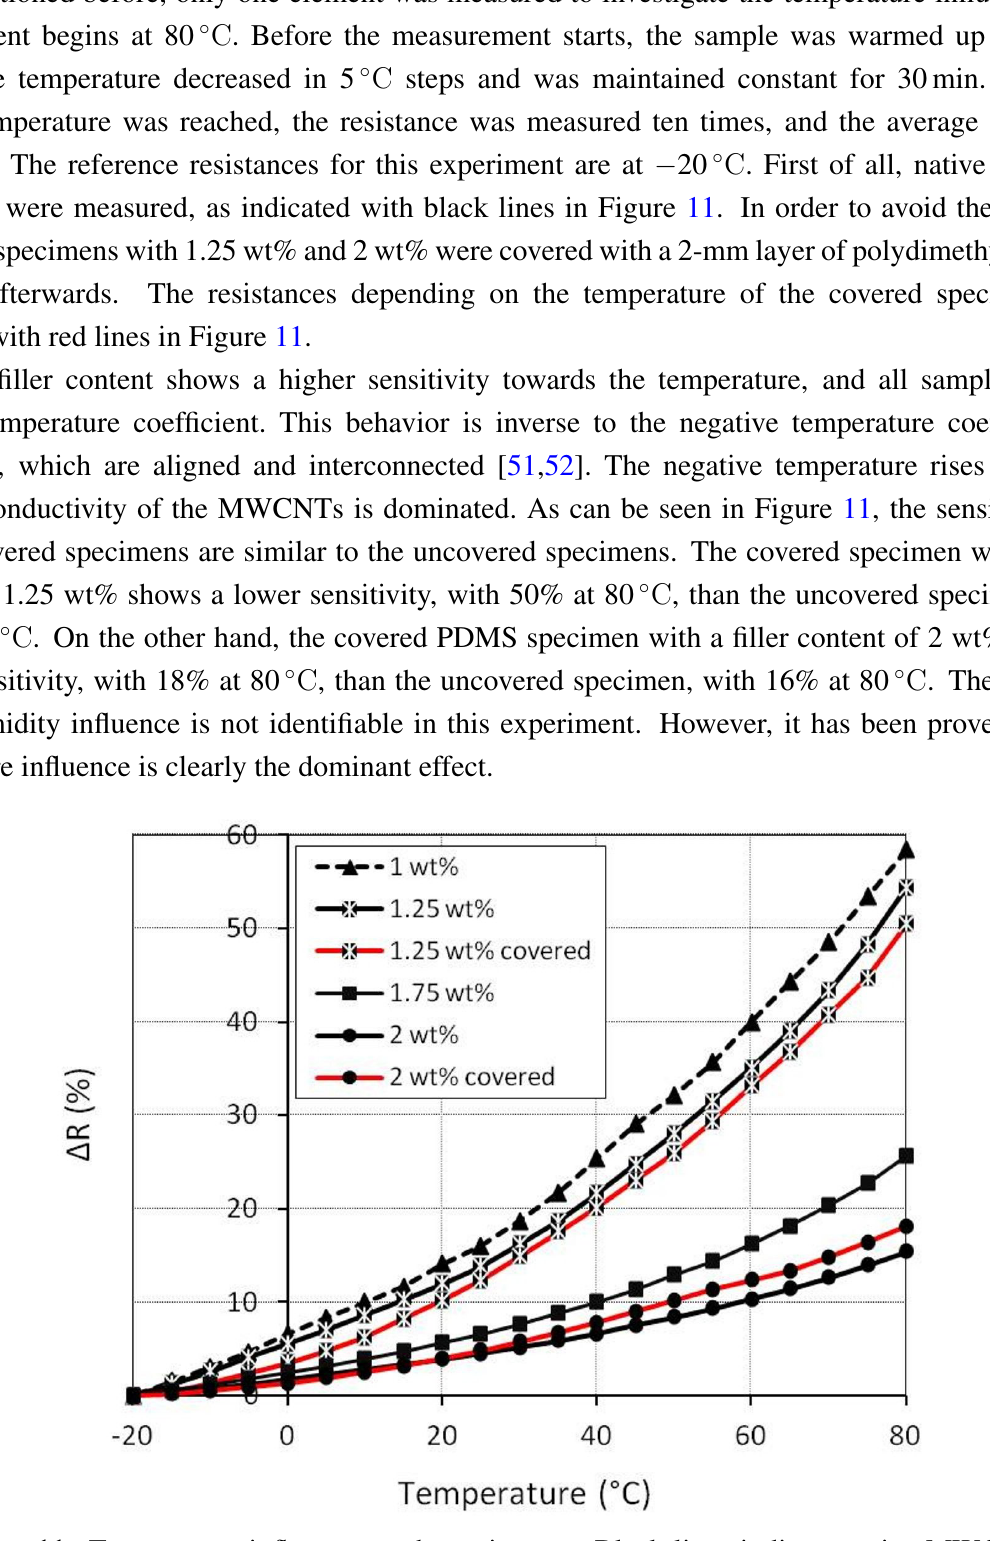
Figure 11. Temperature influence on the resistance. Black lines indicate native MWCNT specimens; red lines indicate PDMS-covered MWCNT